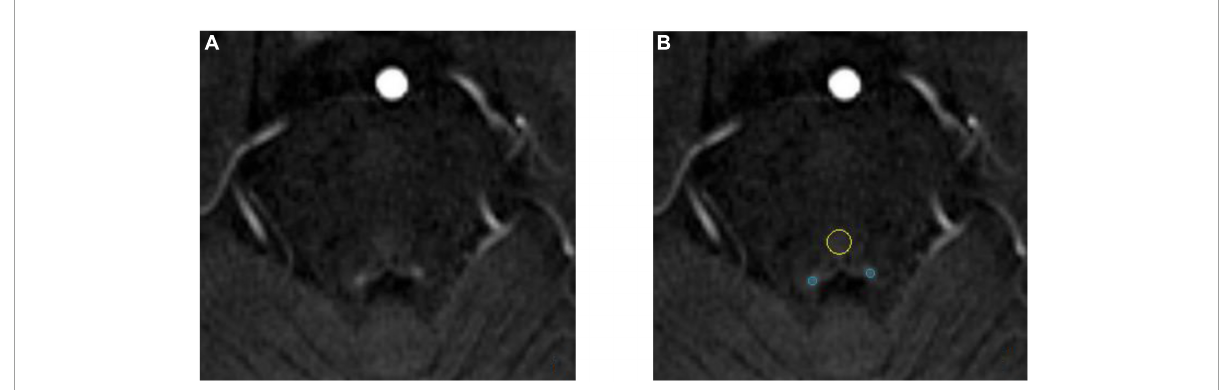
FIGURE4 Schematic diagram of locus coeruleus (LC) signal and the region of interest (ROI) delineation. Both images are from the same 71-year-old healthy control. (A) The locus coeruleus (LC) exhibits relatively high signal after NM-MRI scanning. (B) Schematic diagram of the region of interest (ROI). The blue circle is the LC and the yellow circle is the pontine tegmentum (PT) reference area.